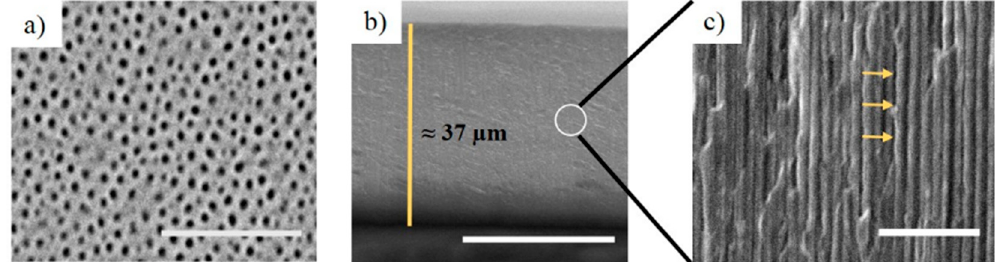
Figure 6. ESEM pictures of as-produced (without any modification) NAA-GIFs for samples with N = 200; ( a ) Top view (Scale bar = 1 µm); ( b ) cross section (Scale bar = 25 µm); ( c ) Magnified view of figure ( b ) showing the modulations in the structure (Scale bar = 1 µm).